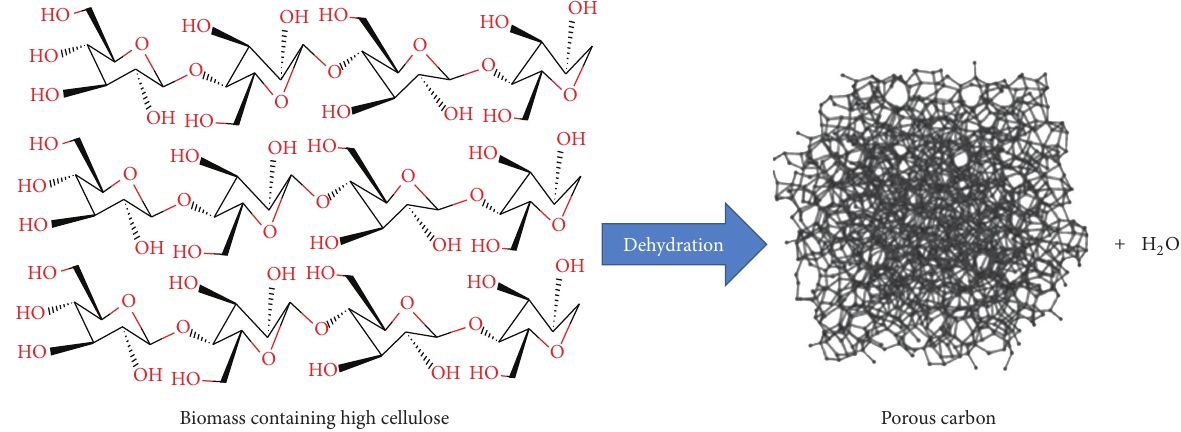
F 1: Transformation of biomass containing high cellulose into porous carbon by dehydration (chemical method).